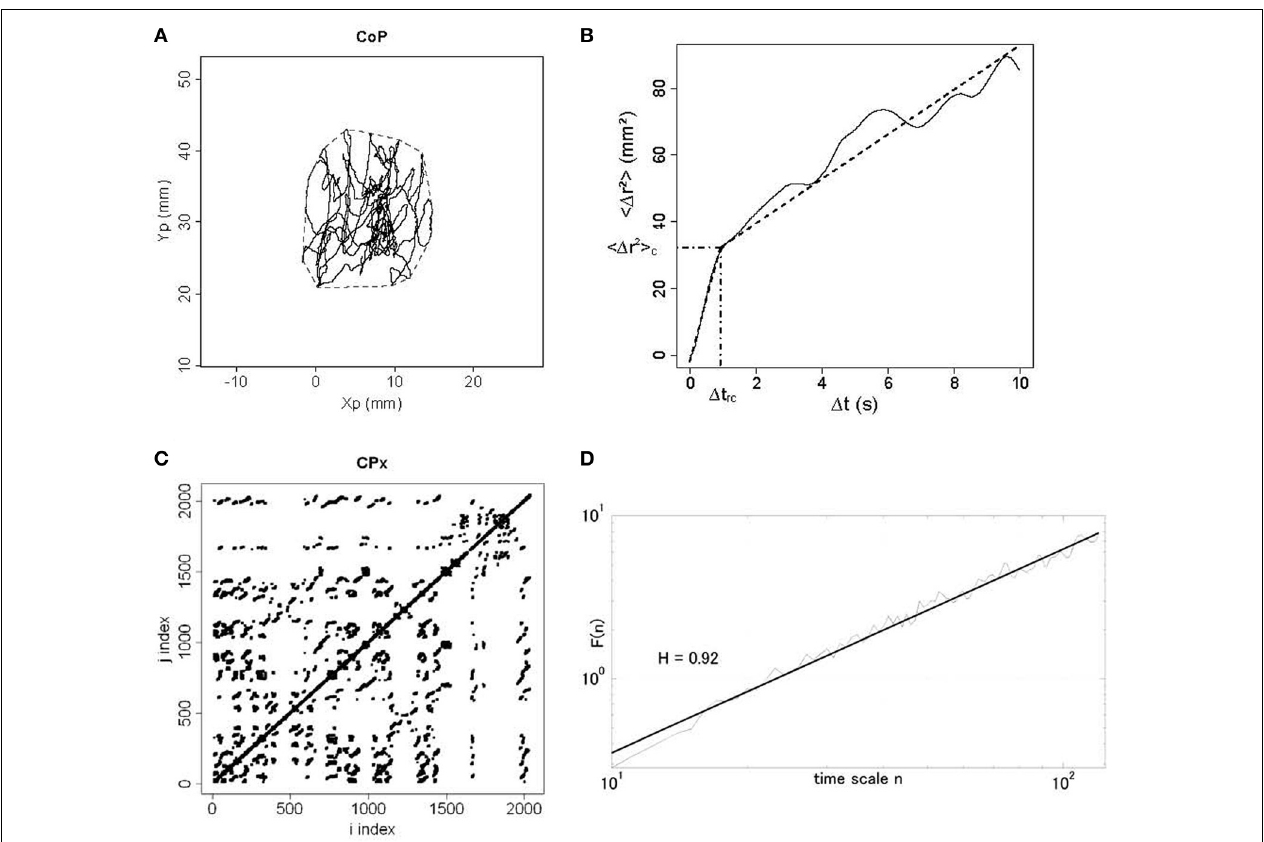
(cid:2) t rc on the x axis. (C) Recurrence quantification analysis plot. Here we show the phase space for mediolateral movement (CPx) for a radius of 3%. It means that for a 3%-radius sphere of the mean distance between data points, we calculated for i = 1 − N and j = 1 − N (where N is the total number of data points) the distance between data points x ( i ) and x ( j ), and darkened every recurrent point for which the distance was below the radius. For i = j , the distance is zero resulting in the central diagonal line. (D) Detrended fluctuation analysisplot.Inalog–logplot,weshowtheDFA α exponent F ( n )inthinlineand the corresponding regression in thick line, as a function of time scale n